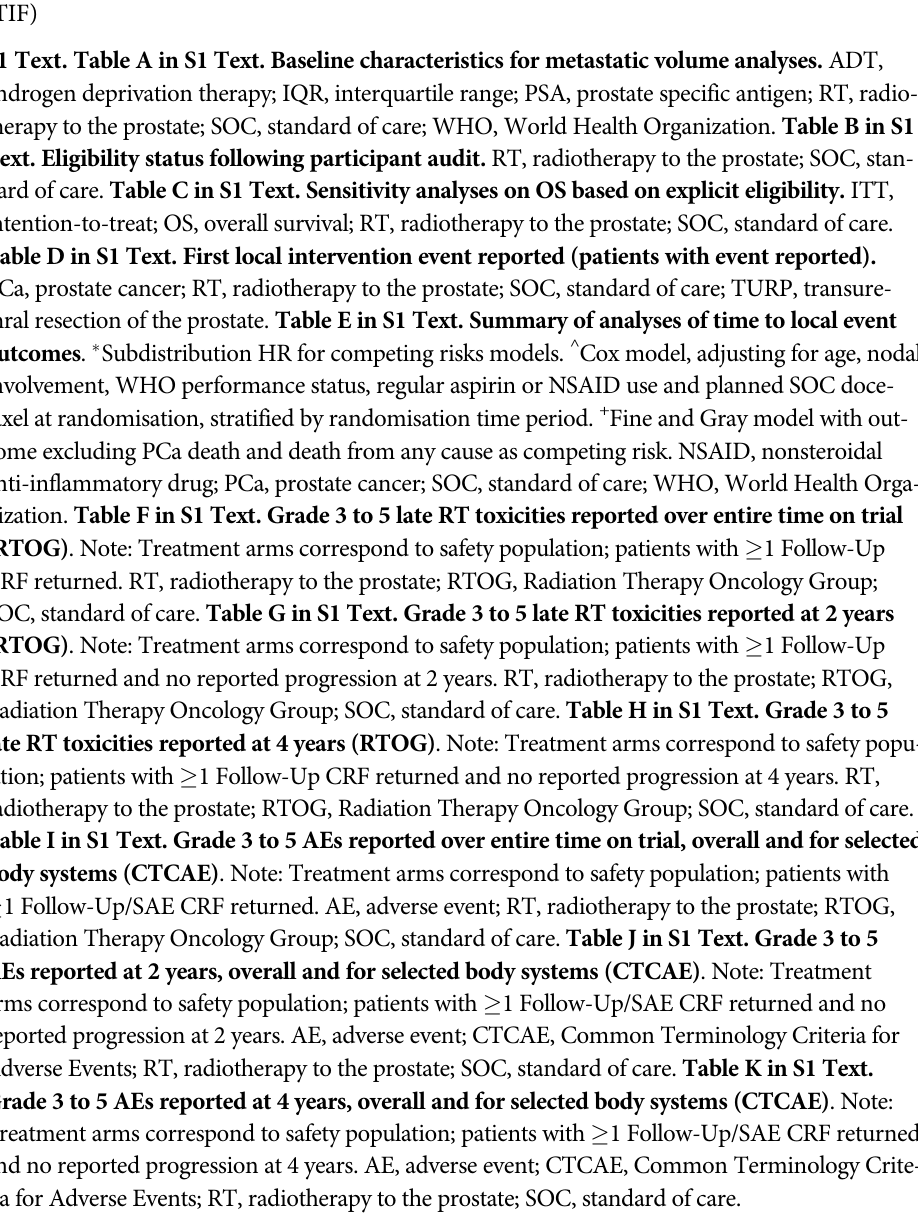
S11 Fig. Time to reported initiation of abiraterone or enzalutamide from FFS event. FFS,